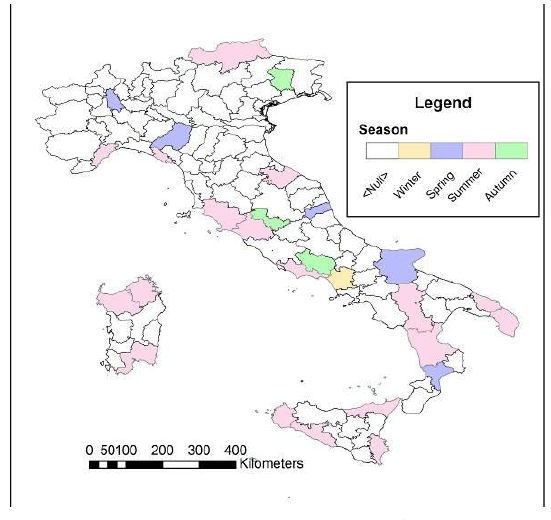
Figure 5. Geographical distribution of pattern